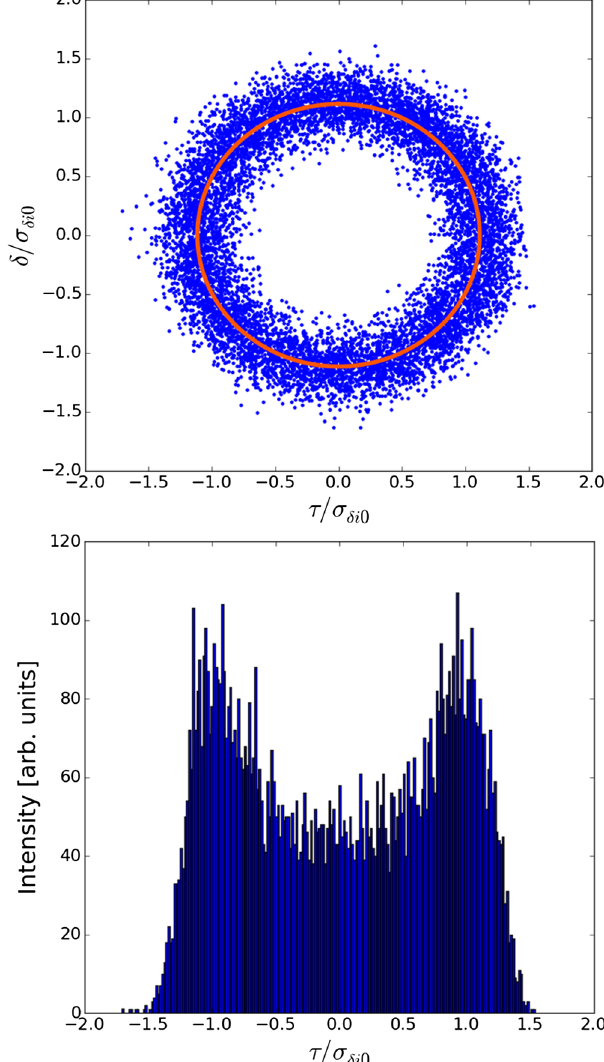
FIG. 4. The ions ’ distribution in the presence of the circular attractor. In the simulations, the ion bunch has a Gaussian initial distribution with the rms energy spread σ δ i 0 . The ions are tracked for 4 × 10 5 synchrotron turns under the influence of the offset friction force shown in Fig. 1. The solid red line shows the location of the attractor of radius j a ¼ v a = ð β c σ δ i 0 Þ with v a found from Eq.